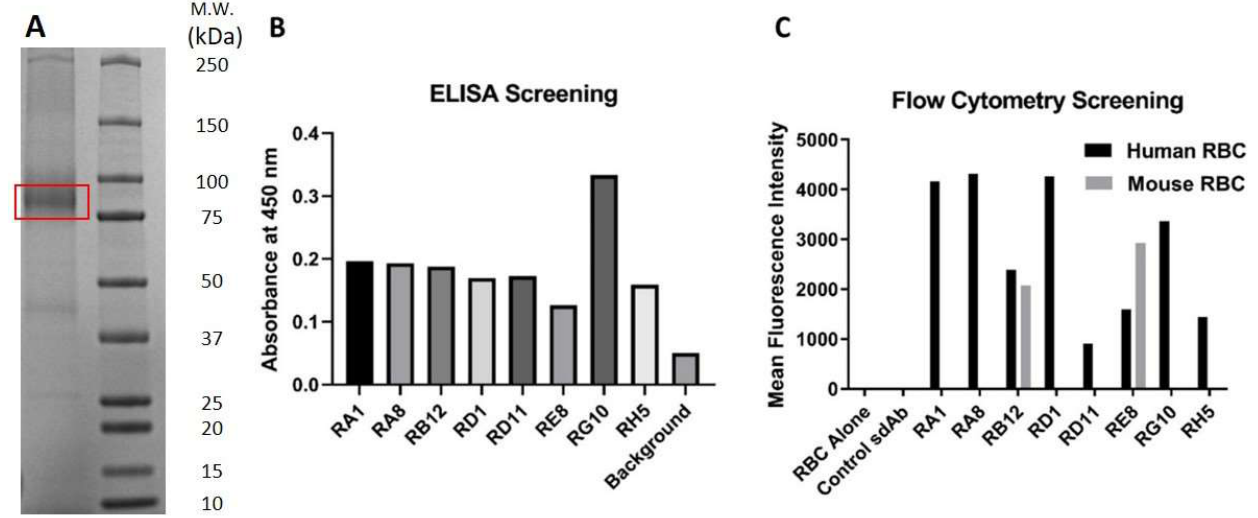
Figure 1. Development of Anti-RBC Single-Domain Antibodies: ( A ) SDS-PAGE analysis of extracted human band 3 protein (b3p) from RBC used for immunization and screening. Extracted b3p from human RBC was exhibited as a prominent band at around 95 kDa with an acceptable purity. The other faint bands are possibly the proteolytic fragments or multimers of b3p. A llama sdAb phage display library was built from PBMCs of a llama immunized with the extracted b3p, panned against human RBC, and screened with ELISA and flow cytometry. ( B ) Assessment of the anti-RBC antibodies binding to the extracted human RBC b3p via ELISA. Eight clones were identified that had a binding signal greater than 3-fold of the background signal. ( C ) Assessment of the anti-RBC antibodies binding to human and mouse RBC by flow cytometry. Human and mouse RBCs were incubated with cell culture media from positive clones. PE-labeled anti-His-tag secondary antibody was used for detection. The calculated mean fluorescence intensity was plotted to quantify binding activity. All of the eight sdAb clones showed binding activity to human RBC, while only RE8 and RB12 showed binding activity to mouse